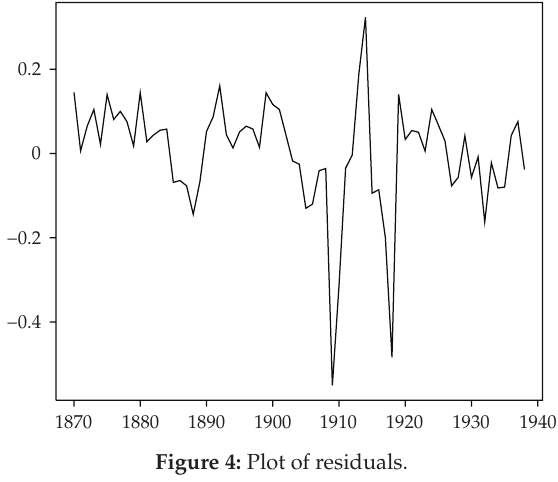
Figure 4: Plot of